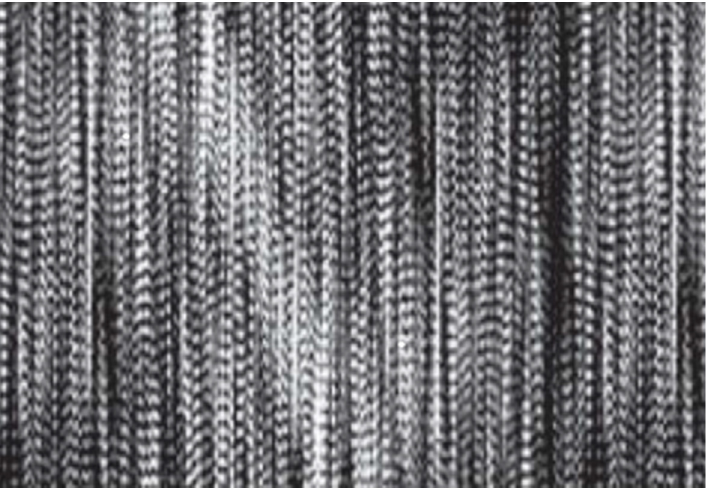
Figure 4. Structure of vertically extended speckles of S. Benton’s rainbow holograms with interference fringes oriented transversely at different angles, formed by the interference of spatially filtered object and reference beams (Figure